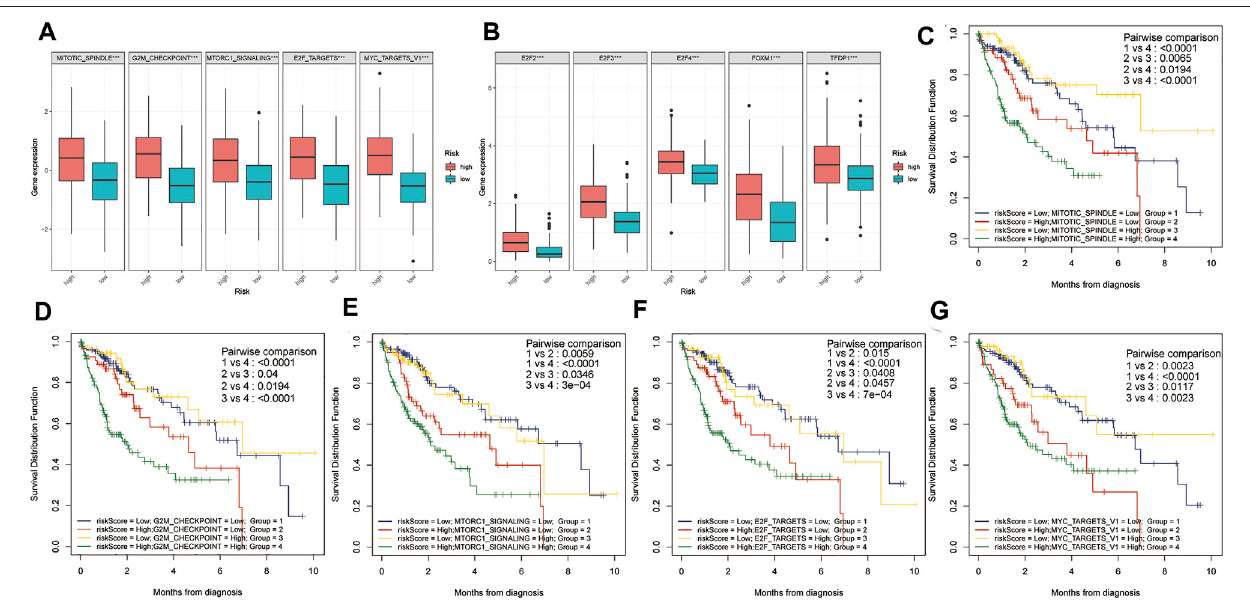
FIGURE 5 | Two-factor survival analysis combining proliferation-related pathways and risk scores. (A) The proliferation-related pathways Z-scores in the high-risk group were signi fi cantly higher than those in the low-risk group. (B) The proliferation-related transcription factor Z-scores of high-risk patients were signi fi cantly higher thanthoseoflow-riskpatients. (C – G) Two-factorsurvivalanalysiscombiningriskscoreandproliferation-relatedpathwayZ-scoresshowedthathigh-riskscoreandhigh proliferation-related pathway Z-Scores predicted the worst prognosis.